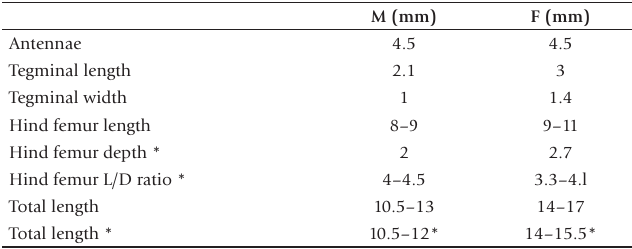
Table 9. Morphometric measurements of Gynmobothrus levipes ab- breviatus